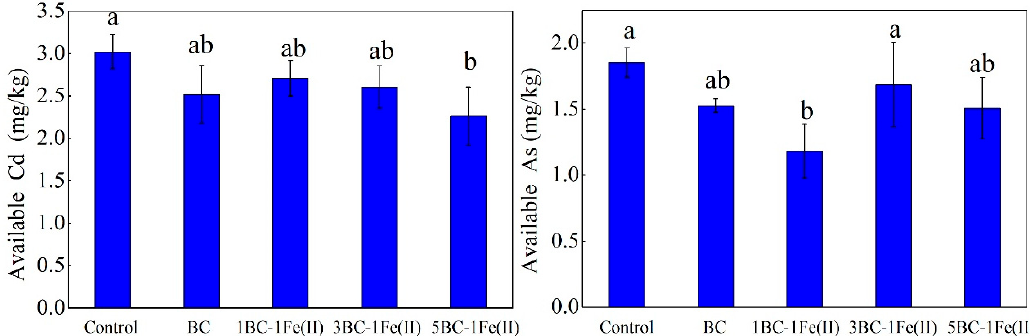
Figure 3. The effect of different treatments on available Cd and As in soil. Different letters indicate that the differences are statistically significant ( p < 0.05). The data are mean ± standard error ( n = 3), bars represent standard errors ( n = 3). Control, untreated soil; BC, applied 1% biochar; 1BC-1Fe(II), applied 0.5% biochar and 0.5% ferrous sulfate; 3BC-1Fe(II), applied 0.75% biochar and 0.25% ferrous sulfate; 5BC-1Fe(II), applied 0.83% biochar, and 0.17% ferrous sulfate.